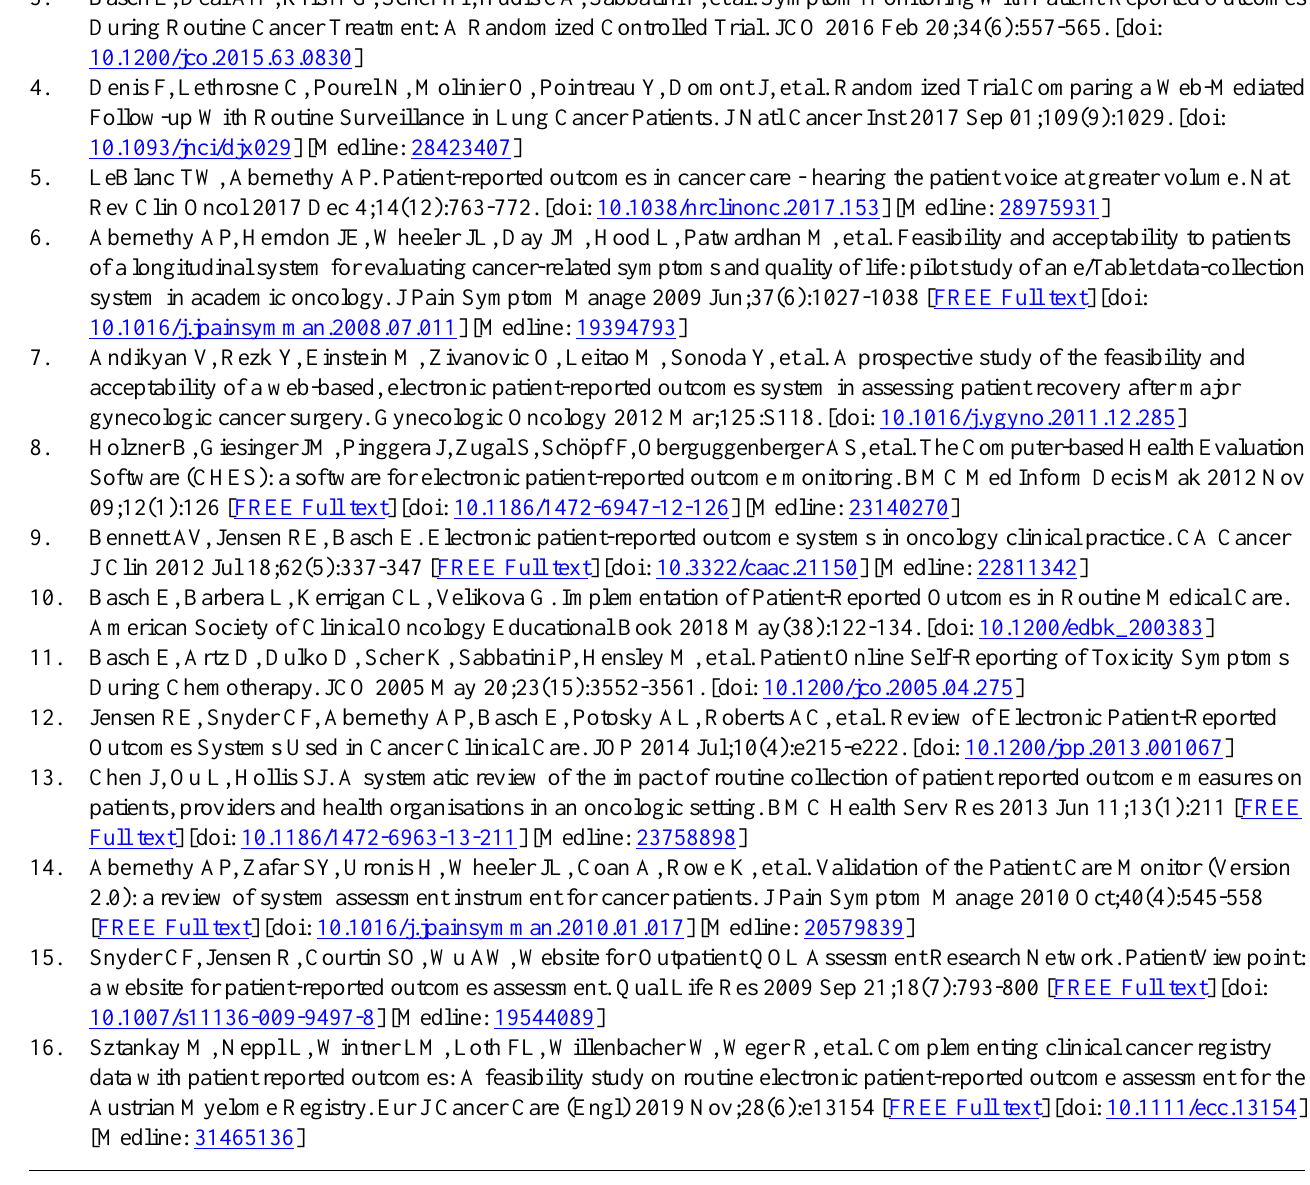
ePRO: electronic patient-reported